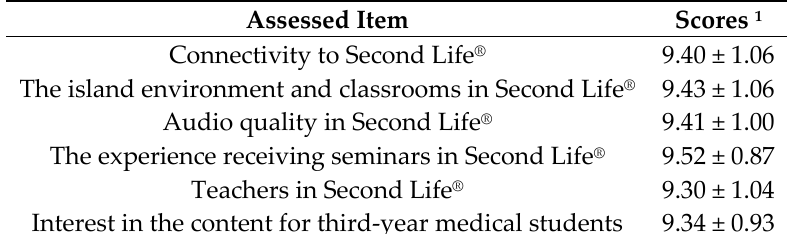
Table 1. Evaluation of the radiology seminars given in Second Life ® .